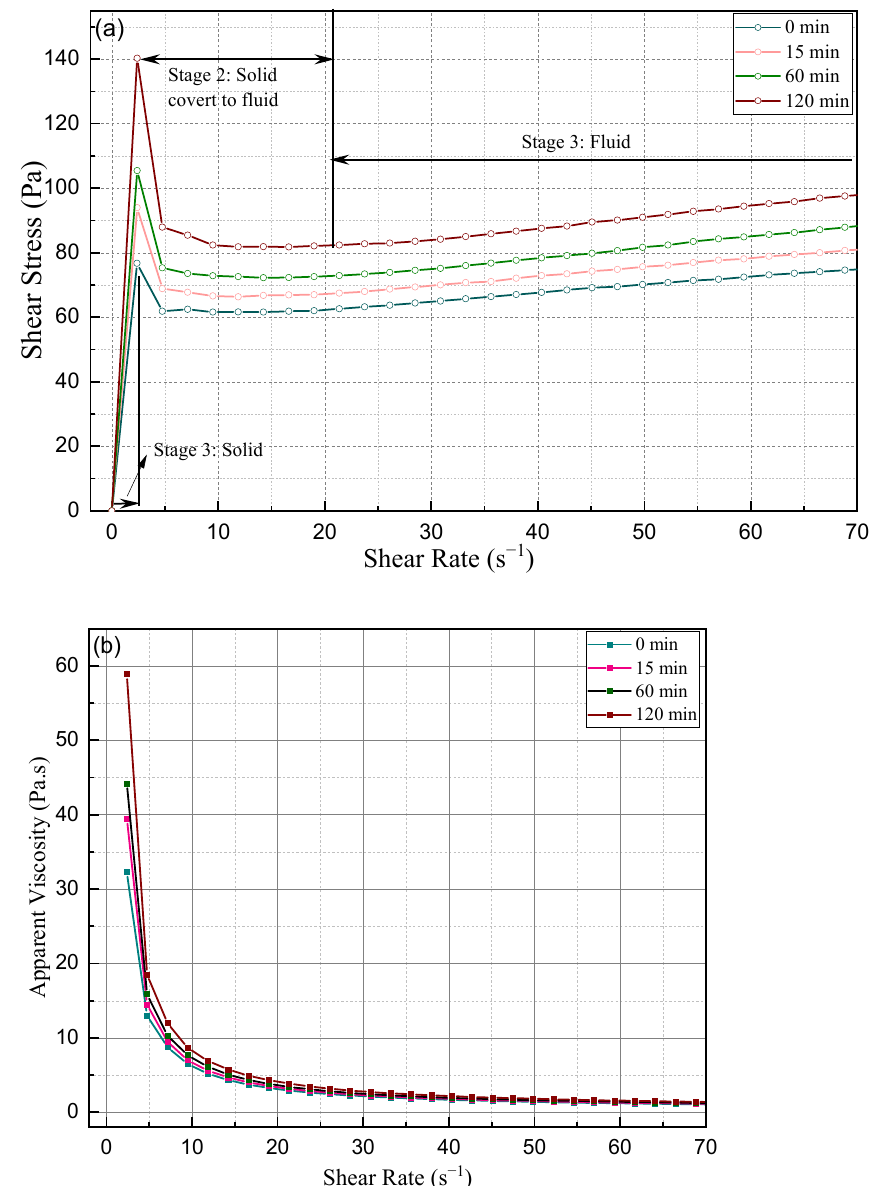
Figure 4. ( a ) Rheological curves of liquefied sediments under different consolidation time. ( b ) Curves of apparent viscosity under different consolidation time.